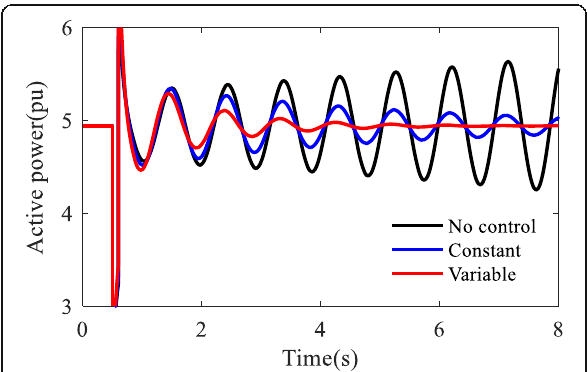
Fig. 13 The angular speed difference between the SG and the PV-VSG when the output power of the PV is 0.09 pu